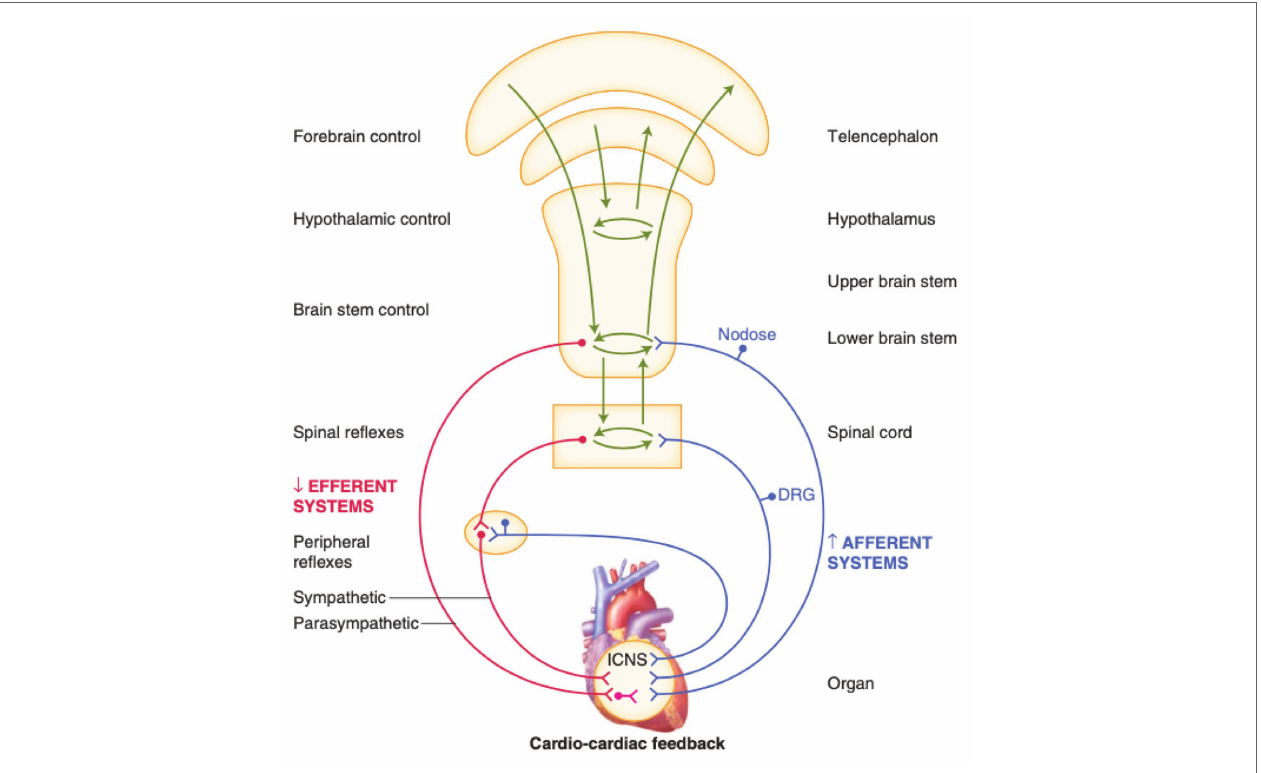
FIGURE 1 | Neural regulation of cardiac function involves multiple nested feedback loops at the level of the heart, peripheral ganglia, and central nervous system. Afferent systems (blue) are mediated through the intrinsic cardiac nervous system (ICNS), dorsal root ganglia (DRG), and nodose ganglia. Efferent systems (red) involve sympathetic, parasympathetic, and local circuit neuron (LCNs). DRG, dorsal root ganglia. ICNS, intrinsic cardiac nervous system. Adapted from Jänig (2014) with